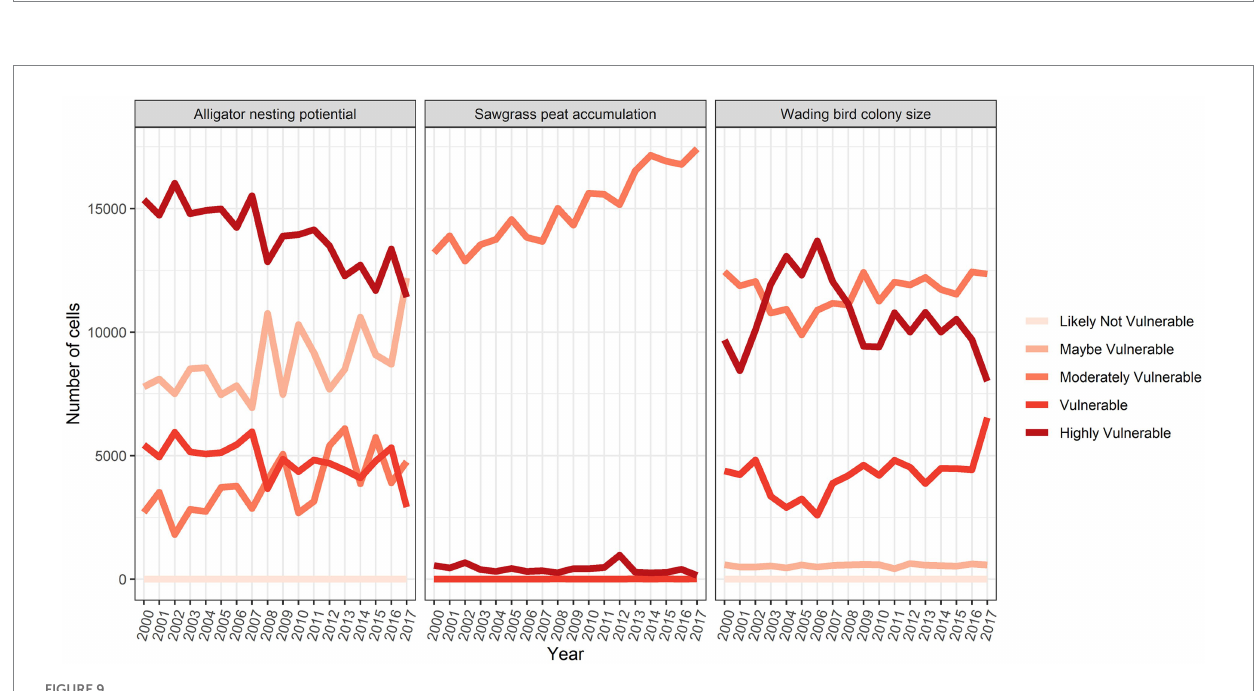
FIGURE 9 Number of grid cells that fell into each vulnerability category in each year across the